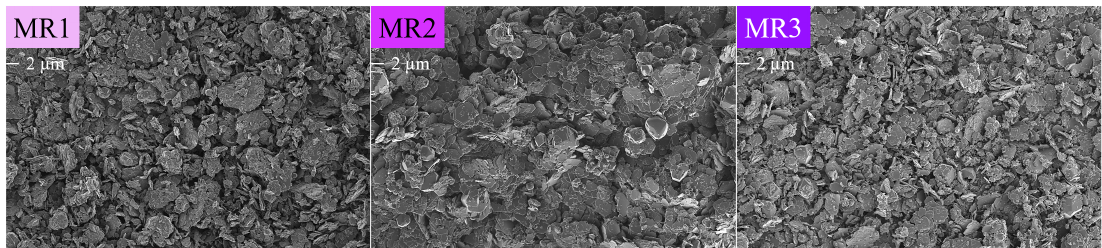
Figure 12. SEM micrographs of the series of molar calcium-to-aluminium ratio MR1 = 3:2, MR2 = 4:2 and MR3 = 6:2 at 1keV and 2k magnification. The scale bar is indicated under the label.